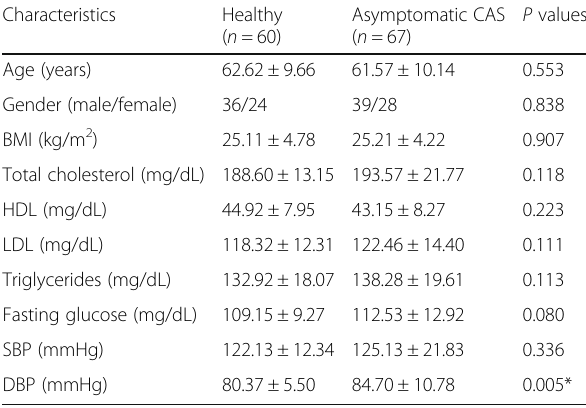
Table 1 Comparison of the baseline data between healthy and asymptomatic CAS group